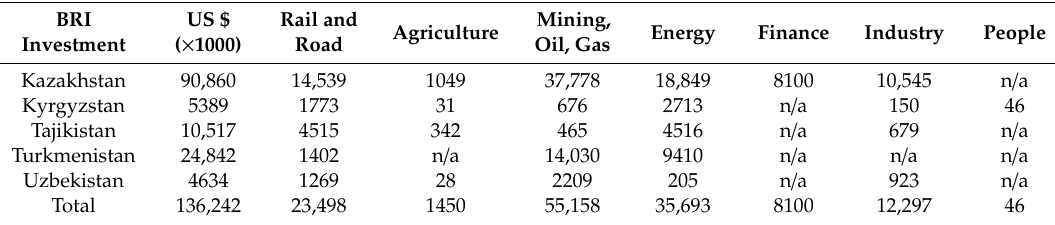
Table 4. Belt and Road Initiative (BRI) investment breakdown in Central Asia. All figures are multiplied by 1000 ( × 1000)